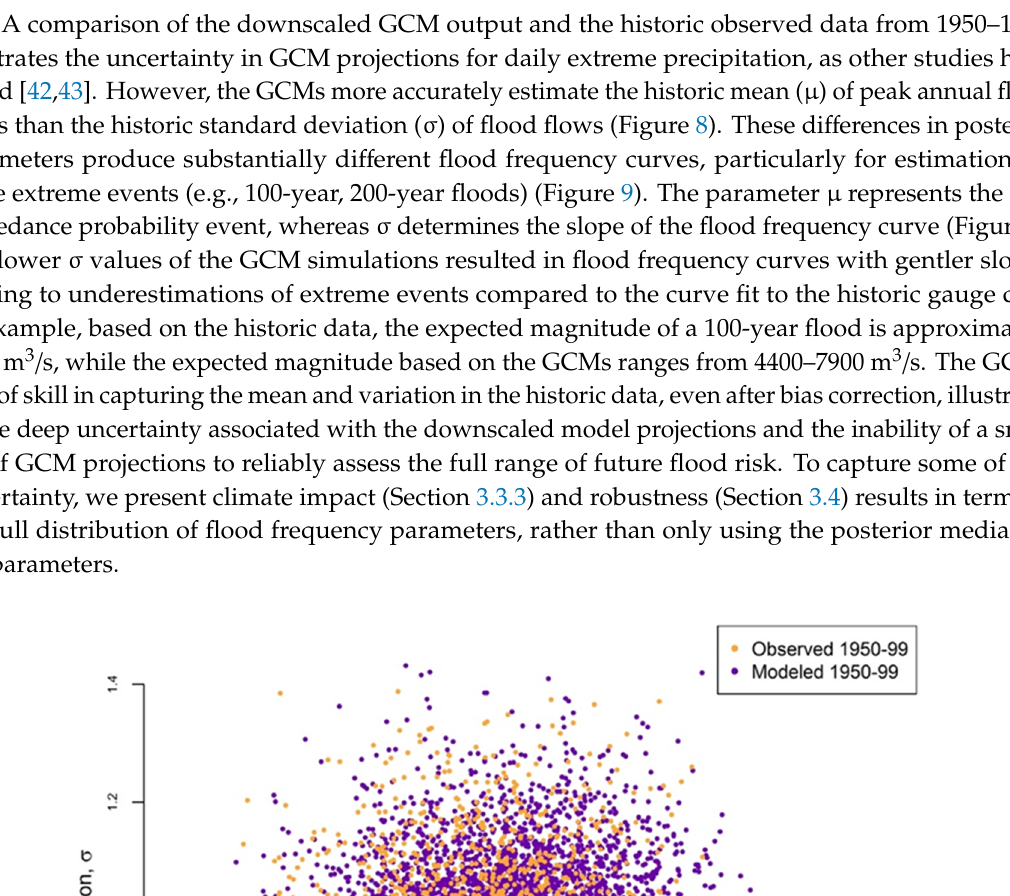
Figure 9. Expected posterior flood frequency curves derived from observed streamflow data (orange) and GCMs forced with observed parameters from 1950–1999 (purple).